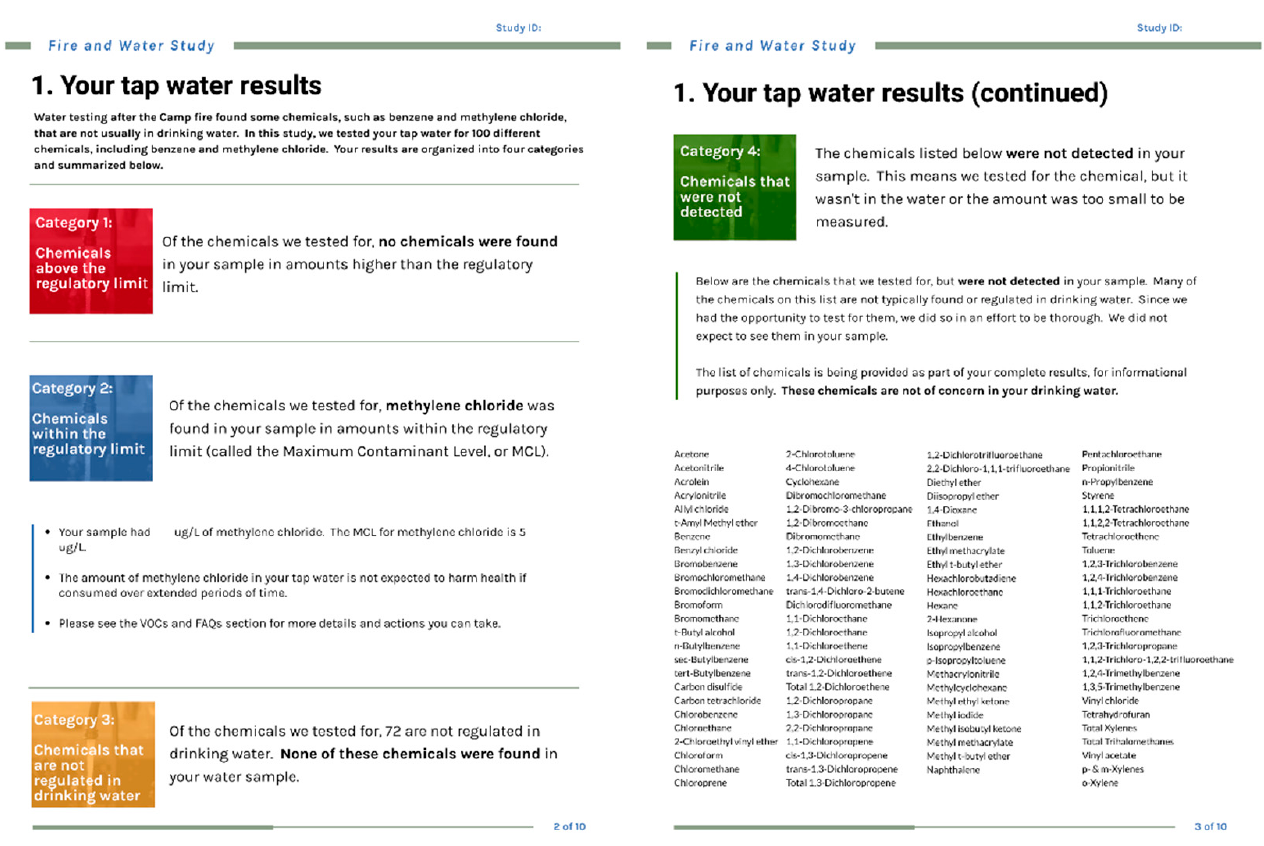
Figure 2. Example of a participant’s individualized results return report.